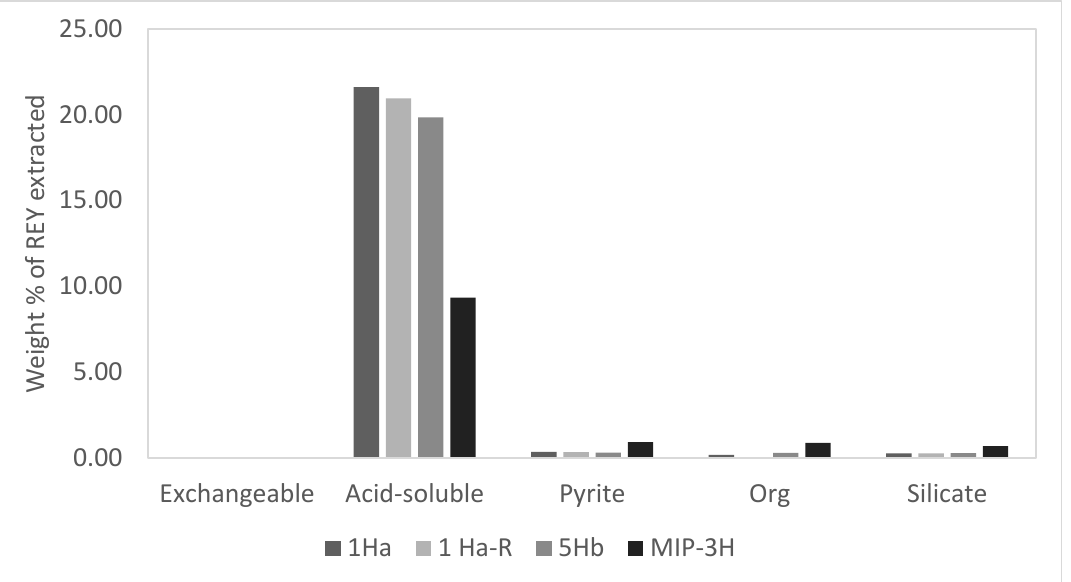
Figure 6. Percentage of REY extracted from each phase. The REY content in the residual matter was not determined.